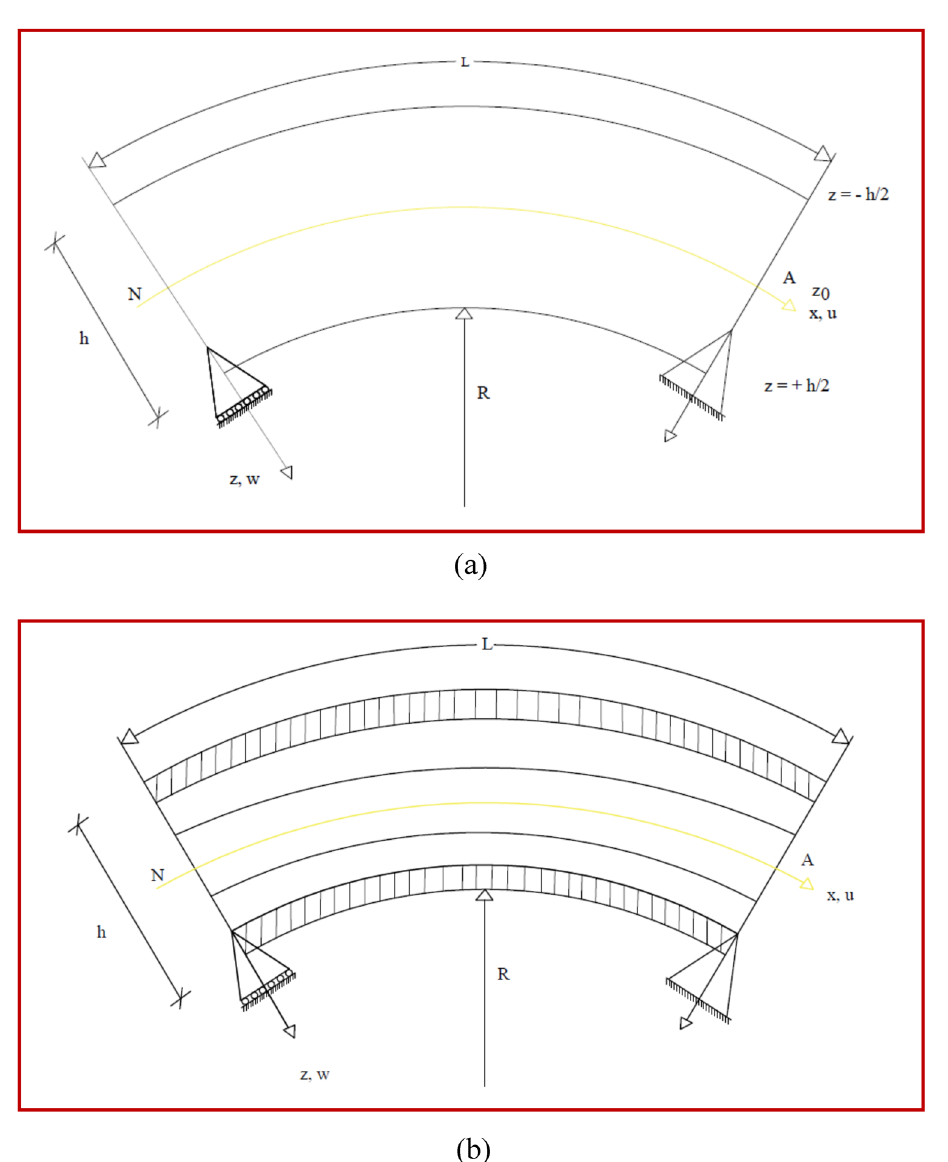
Figure 1: Geometry of ( a ) two - layered composite arches subjected to UDL and ( b ) sandwich arches subjected to